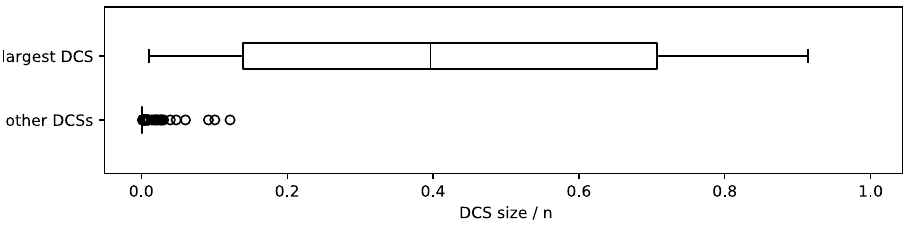
Figure 3. Survey of the dilation choice sets of 17 real networks from various applications and of various sizes. In each network the size of the largest DCS ranged from 1 to 91% of the network size, while the remaining (non- largest) DCSs tended to be small (maximum 12%, average 0.1% of the network